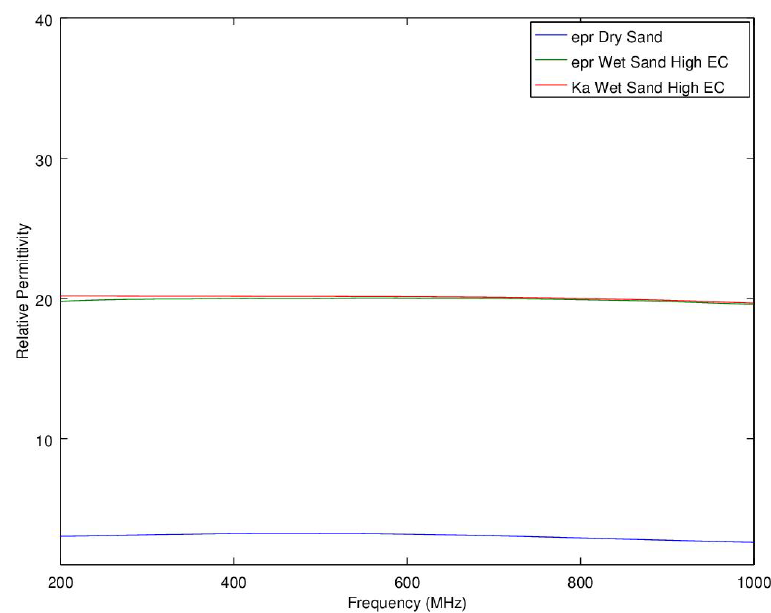
Figure 8. This chart shows that in a low surface area material, such as sand, there’s little difference between apparent permittivity, Ka, and dielectric constant, ε′ . Of importance is that for low surface area soils, TDR measuring Ka would perform just as well as a network analyzer would by using a frequency domain